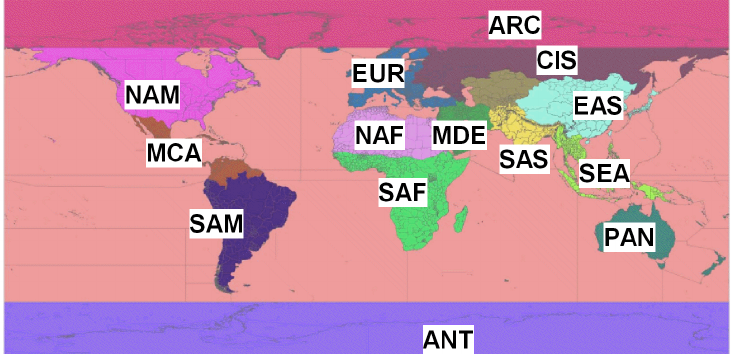
Figure 1. Definition of the source regions used in this study. NAM (US and Canada), EUR (Europe and Turkey), SAS (South Asia), EAS (East Asia), SEA (South East Asia), PAN (Australia and New Zealand), NAF (Northern Africa), SAF (Sub Saharan Africa), MDE (Middle East), MCA (Middle and Central America), SAM (South America), CIS (Russia and Central Asia), ARC (Arctic Circle above 66 ◦ N), and ANT (Antarctic below 60 ◦ S), as in AMAP/UNEP